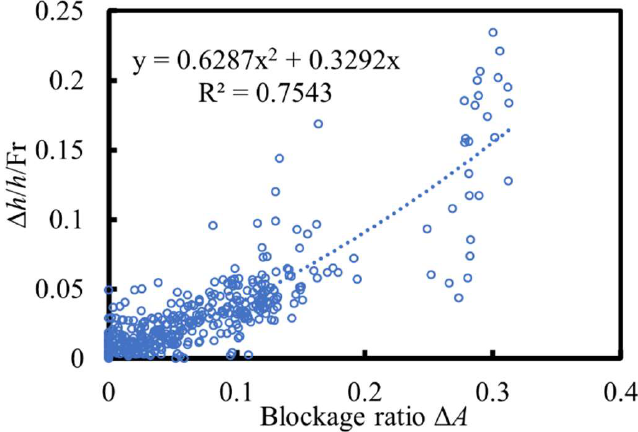
Figure 9. Correlation between the debris-induced hydraulic head and blockage ratio ∆𝐴